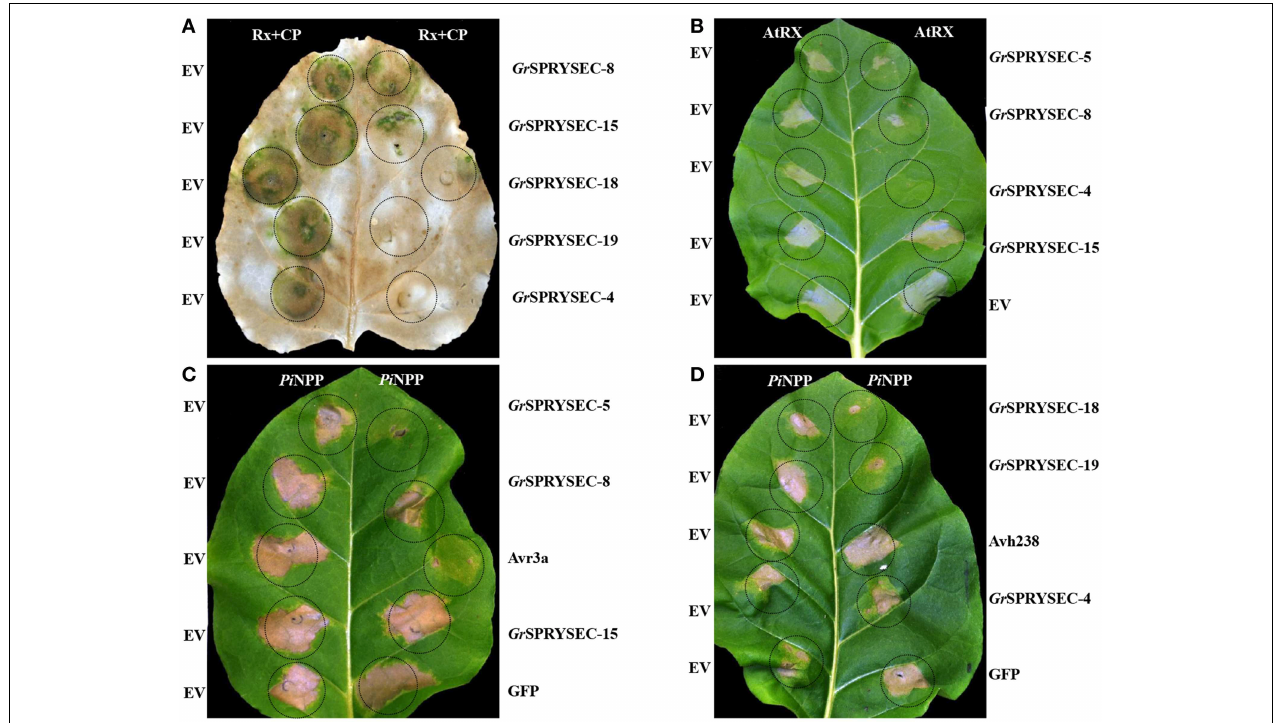
FIGURE 2 | Suppression of cell death induced by NB-LRR and Pi NPP proteins by Gr SPRYSECs in N. benthamiana and N. tabacum . (A) N. benthamiana leaves were co-infiltrated with Agrobacterium carrying binary vectors expressing Rx, CP and P38 together with either empty vector (EV, left hand side) or the indicated effectors expressed from pEAQ35S (right hand side). Three days DPI, leaves were decolorized with methanol to highlight cell death reactions. (B) N. tabacum leaves were co-infiltrated with Agrobacterium containing